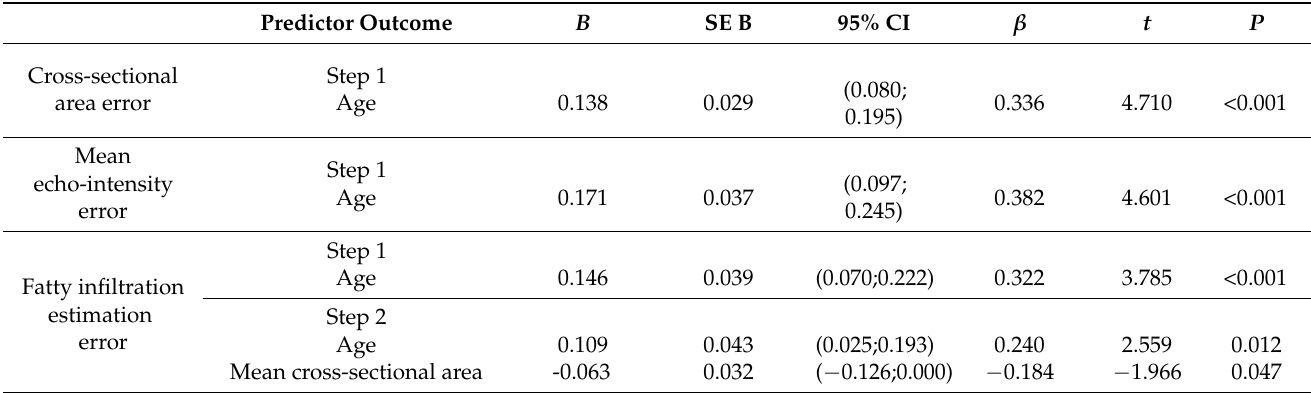
Table 4. Summary of the regression analyses to determine individual contributors to US measure- ment